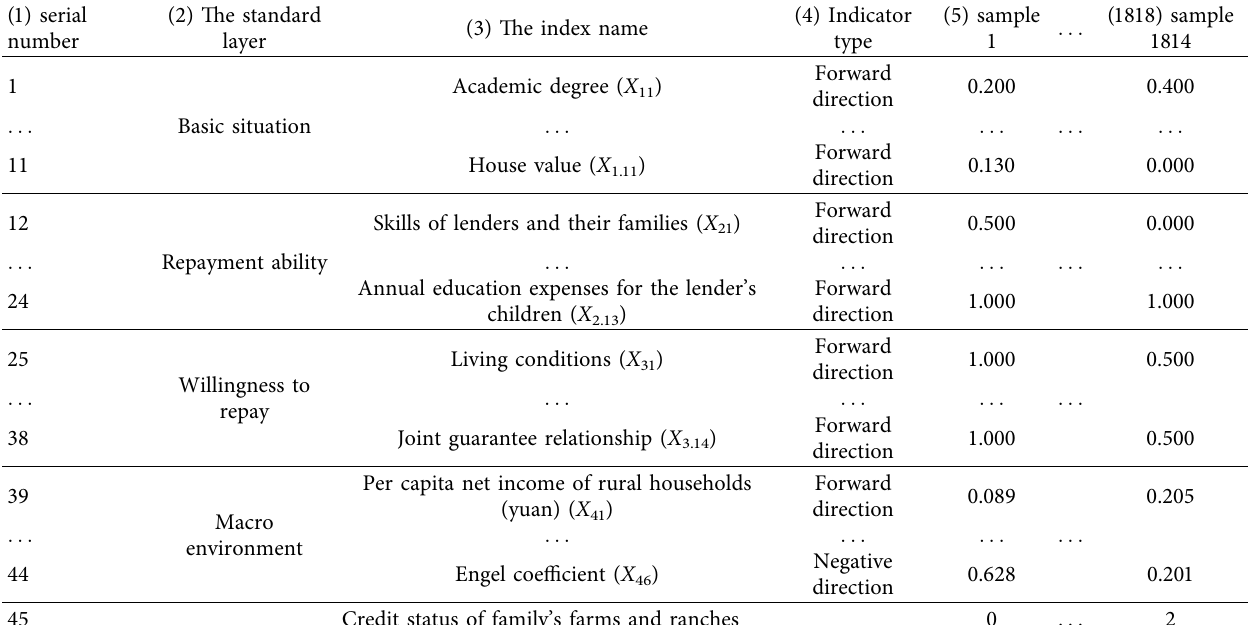
Table 2: Index system of household farming and pastoral land selection at sea.